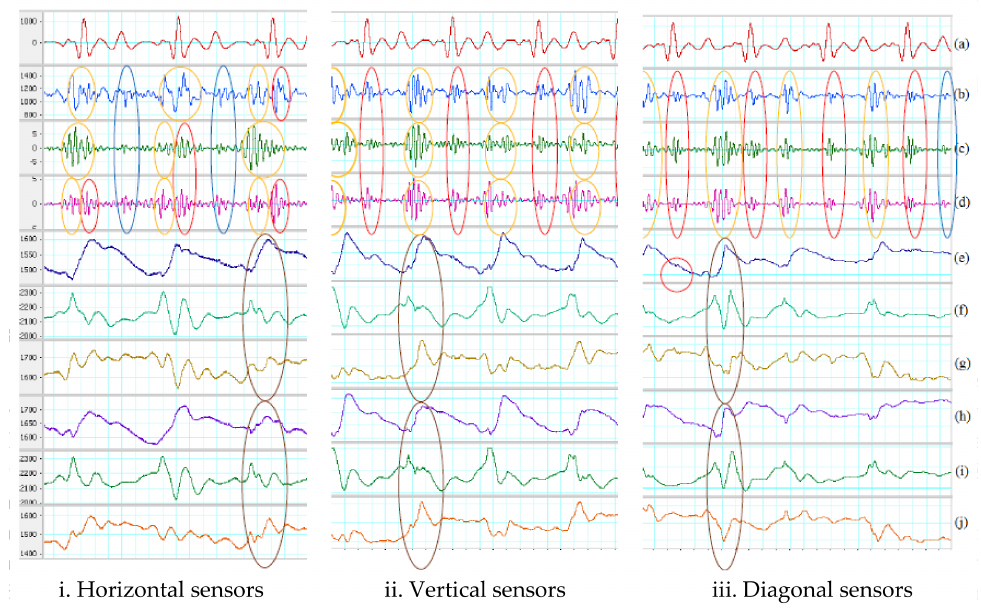
Figure 11. Digital processing on walking motion. ( a ) Filtered ECG (5–20 Hz). ( b ) Filtered SCG with SUBTRACTOR. ( c ) Filtered total acceleration. ( d ) Filtered z-axis acceleration. Red ovals indicate recognized systoles. Blue ovals indicate determined diastoles. Orange ovals show results of different response. Green ovals illustrate better noise suppression. ( e ) First sensor z-axis. Red circle indicates a small SCG signal. ( f ) First sensor y-axis. ( g ) First sensor x-axis. Brown oval indicates high-energy portion of walking. ( h ) Second sensor z-axis. ( i ) Second sensor y-axis. ( j ) Second sensor x-axis. Brown oval indicates high-energy portion of walking.